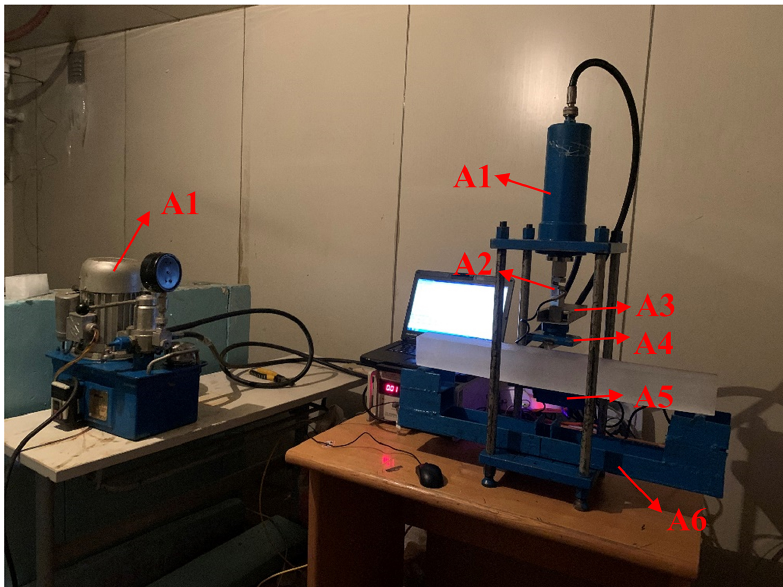
Figure 2. Experiment equipment for the three-point bending test: (A1) hydraulic system; (A2) force sensor; (A3) aluminum plate; (A4) line-load pressing plate; (A5) laser displacement sensor (behind the ice sample); and (A6) simply supported